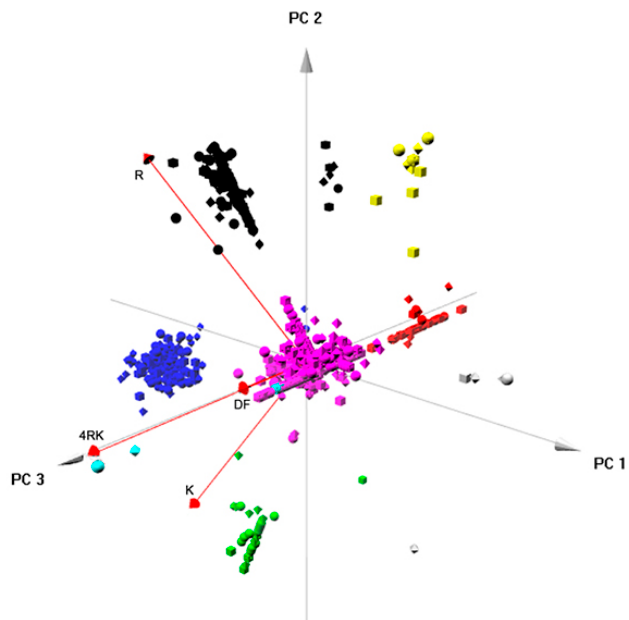
Figure 7. Component analysis for the protein sets corresponding to the arginine-framed tripeptide-relatedcheckpoint. PCAwasperformedusingthepackage“pca3d”fromRprogramming[31]. Datacorrespondingtothecombinationsofthemedianoftheamountofeachproteinimmunoprecipitated with each CFTR variant (or pulled-down with each set of peptides) calculated before were used for PCA analysis. The PCA scores corresponding to the three main components were plotted in a scatter plot in which the position along the axes shows the PCA score of the protein. Clustering was performed using hierarchical agglomerative clustering through the standard R function “hclust” and using average linkage as a clustering